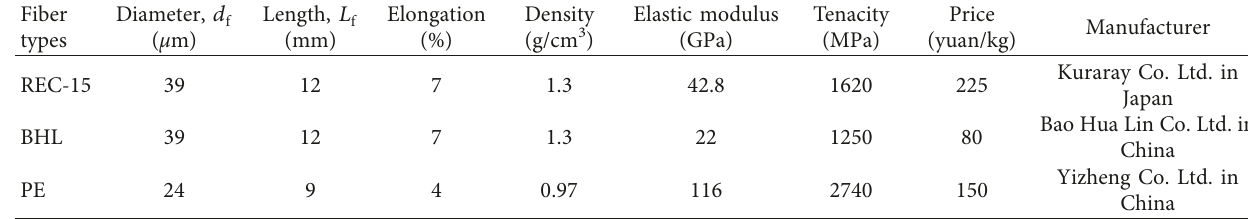
Table 2: Physical and mechanical properties of all fibers.